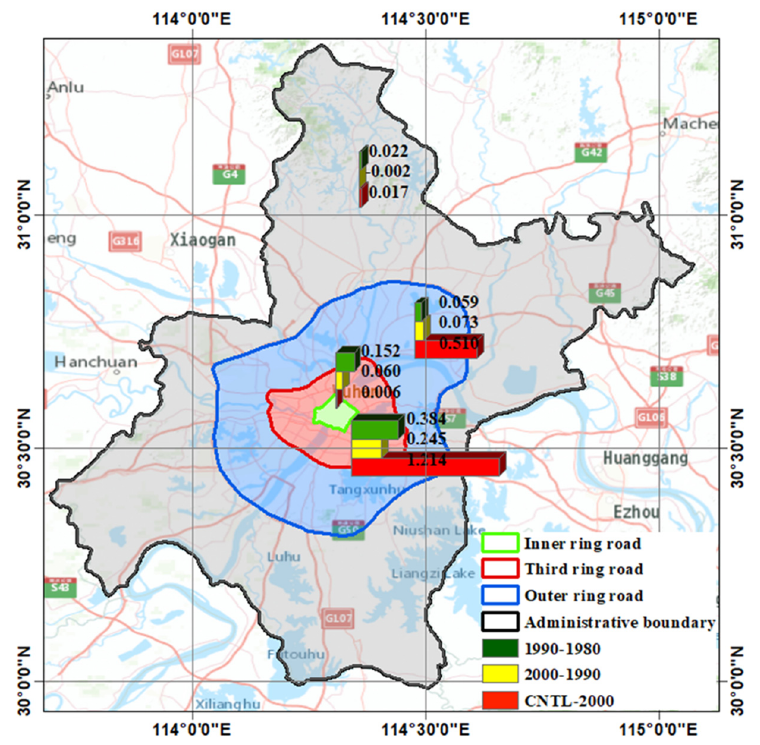
Figure 9. The statistics of LST_RI (Unit: K) of every decade (each bar chart represents the statistical results within the region where it is located. i.e., the bar chart located between the third ring road and the outer ring road represents the statistical results outside the third ring road but inside the outer ring road).